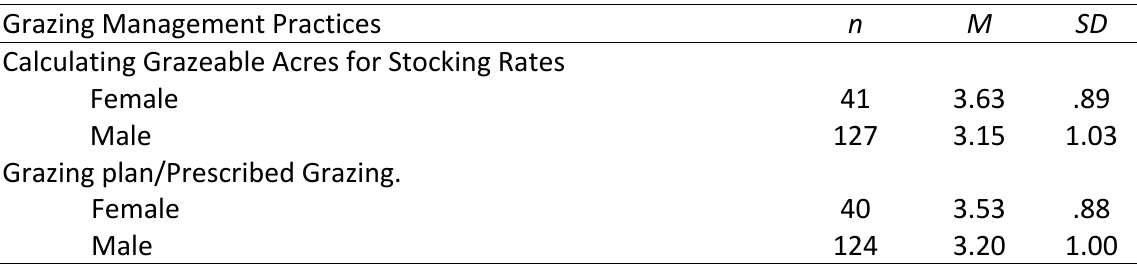
Descriptive Statistics of Gender on Intention to Adopt Grazing Management